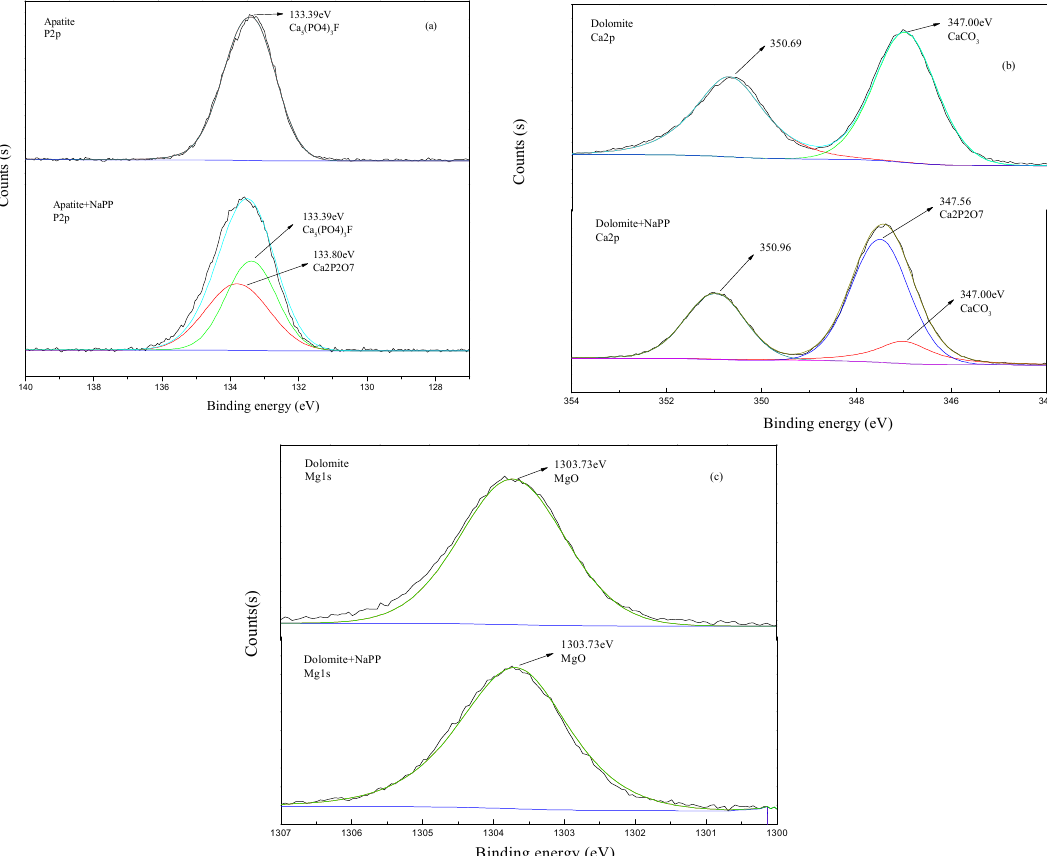
Figure 7. Fitting of X-ray photoelectron spectroscopy (XPS) spectra of ( a ) P2p of apatite, ( b ) Ca2p of dolomite and ( c ) Mg1s of dolomite before and after treatment with NaPP.